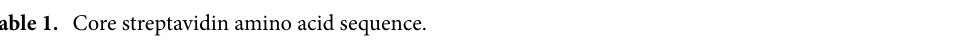
Table 1. Core streptavidin amino acid